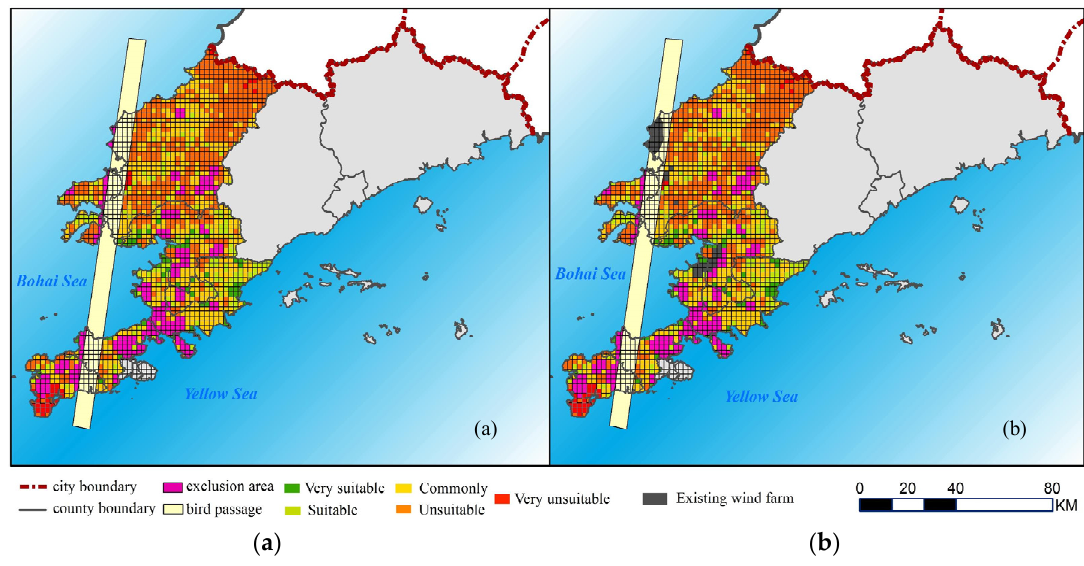
Figure 4. Comparison of the evaluated result to the existing wind farm. ( a ) Suitability evaluation results obtained by fuzzy AHP and VIKOR integration method; ( b ) Locations of existing wind farms. Table 2. Index score of points in the most suitable